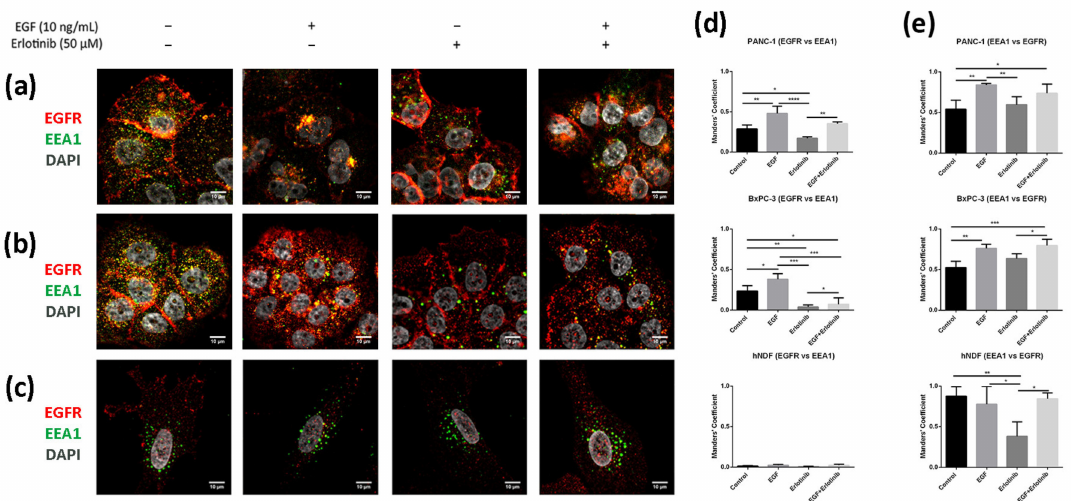
Figure 9. Colocalization analysis of the EGFR and EEA1 (early endosomes) in cells incubated with EGF, erlotinib or both in 2D cultures. EGFR (red) and EEA1 (green) immunofluorescence counterstained with DAPI (grey) in ( a ) PANC-1; ( b ) BxPC-3 and ( c ) hNDF cells. Scale bars represent 10 µ m; ( d ) Manders’ colocalization coefficients showing the proportion of EGFR overlapping with EEA1; ( e ) Manders’ colocalization coefficients showing the proportion of EEA1 overlapping with EGFR. Statistical differences are indicated as * for p < 0.05, ** for p < 0.01, *** for p < 0.001 and **** for p <